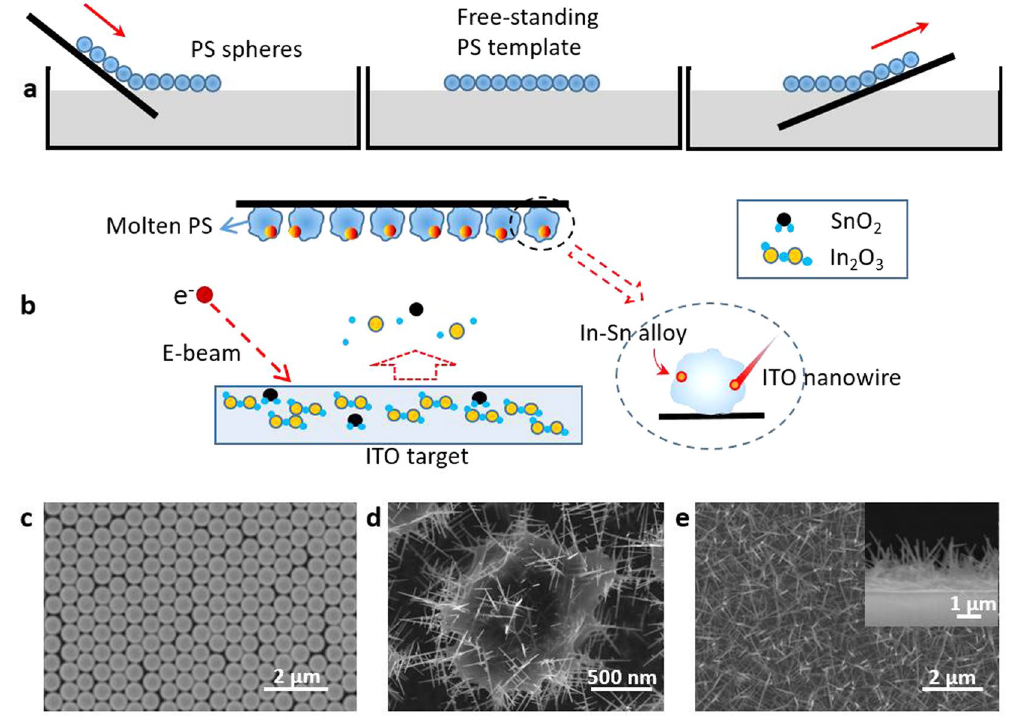
Figure 1. Fabrication process of ITO nanowire networks. ( a ) Self-assembly process of PS spheres on substrate. The master was treated 30 s with oxygen plasma to get a hydrophilic surface. The PS sphere dispersion slowly reached the surface of deionized water along the master. The spheres were gathered into a monolayer film by using sodium dodecyl sulfate (SDS). The substrate was inserted below the PS sphere membrane, and then was made outward by a small angle and a slow rate. ( b ) ITO source (In 2 O 3 :SnO 2 = 90:10, wt%) was deposited on the template by e-beam at a deposition rate of 0.1 nm/s for 20 min, with the chamber temperature stabilizing at 300 °C and pressure less than 5 × 10 − 4 Pa. It took 5 min to hold the surface of PS spheres in molten state before depositing. In-Sn alloy were absorbed by the melted PS spheres, and the nanowires grew based on these nucleation point. ( c ) The PS assembly on substrate. ( d ) ITO nanowires were growing based on melted PS sphere. ( e ) The ITO nanowire network was fabricated by annealing at 470 °C for 5